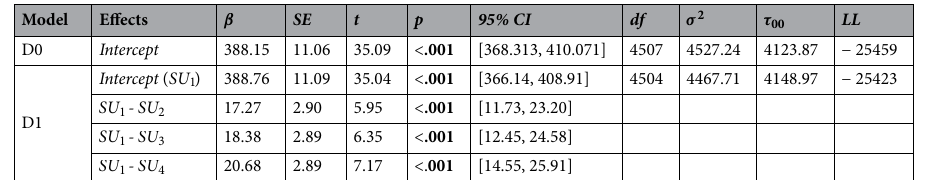
Table 4. LMM analysis of the effect of expected surprise on the maximum velocity of the visually-guided saccad. β fixed effect coefficient, LL log-likelihood, σ residual errors. Significant values are in